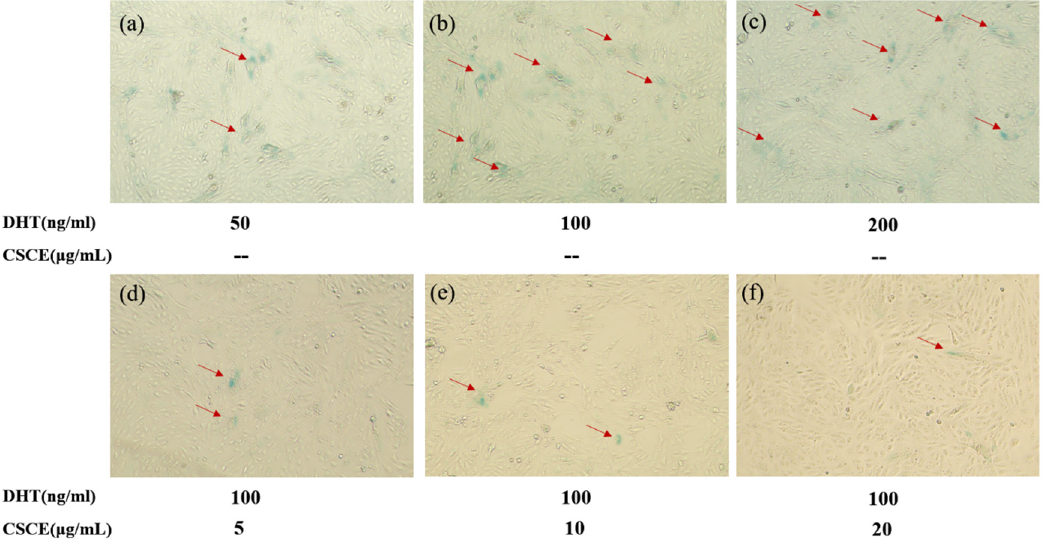
Figure 6. SA- β -Gal in DPCs of different groups was stained and photographed. ( a – c ) 50 ng/mL, 100 ng/mL and 200 ng/mL DHT-treated group; ( d – f ) 100 ng/mL DHT and 5, 10, and 20 μ g/mL CSCE co-treated DPCs group.